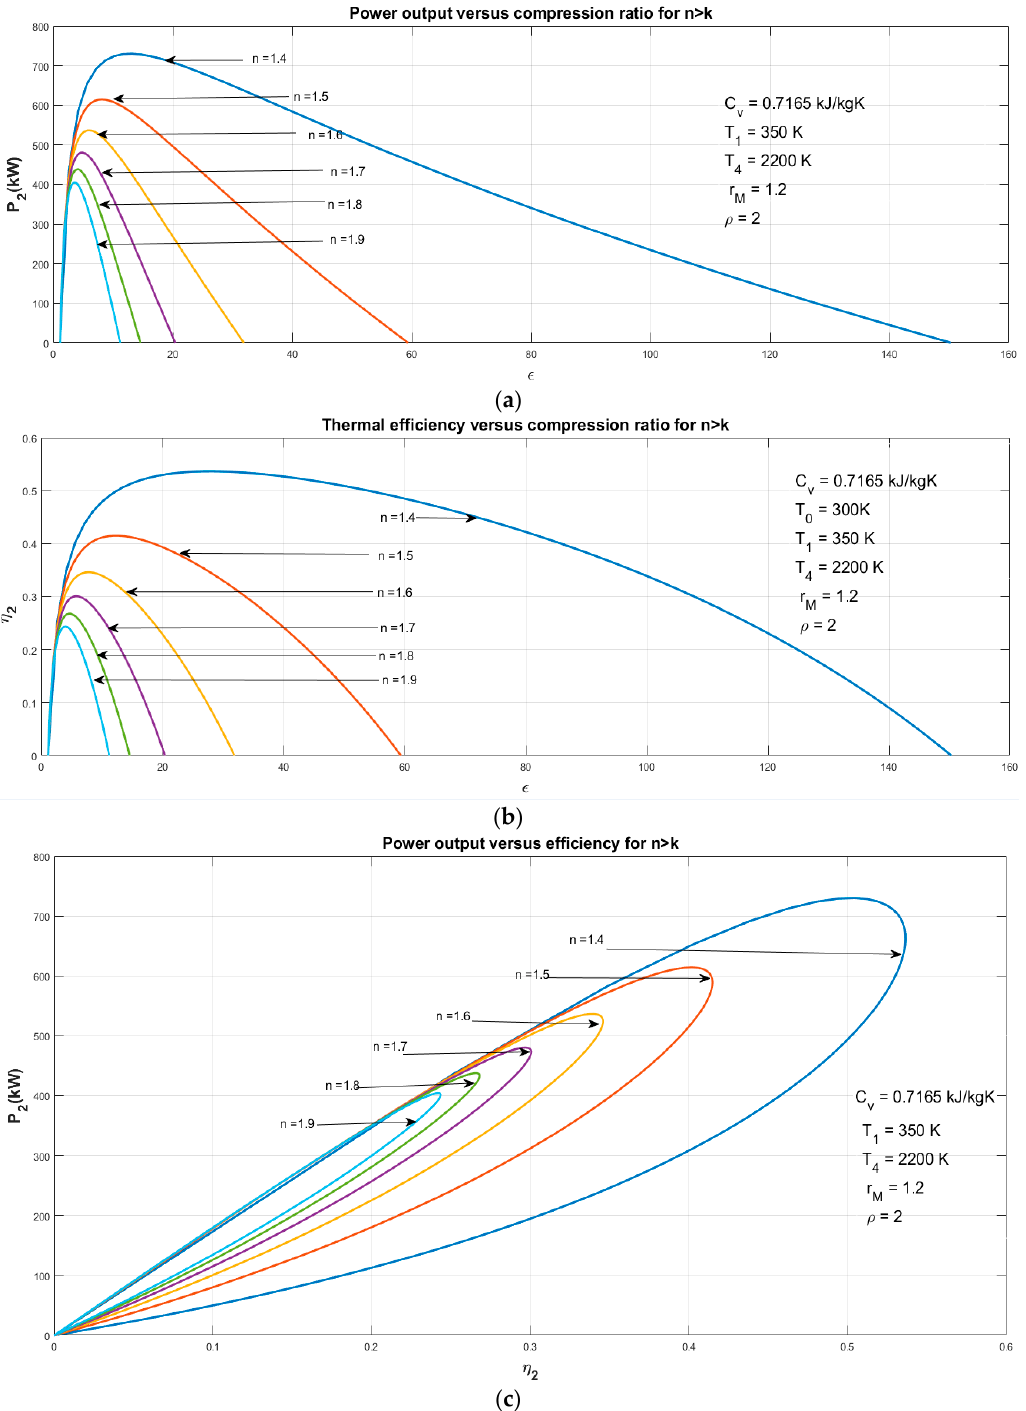
Figure 6. Impact of n ( n > k ) on P 2 – ε ( a ), 𝜂 2 – ε ( b ) and P 2 – 𝜂 2 ( c ).